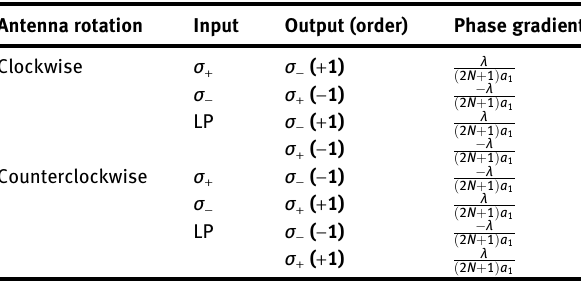
Table  : Cross-polarized transmissionfordifferent combinations of the input polarization and